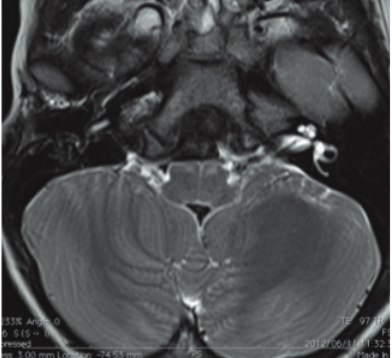
Fig. 4. Axial T2-weighted MRI at the